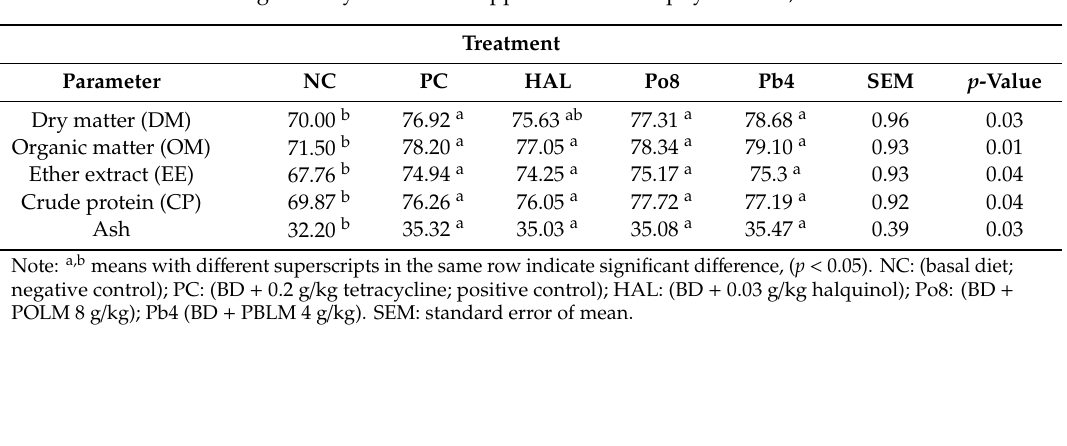
Table 3. Nutrient digestibility of broilers supplemented with phytobiotics, HAL and